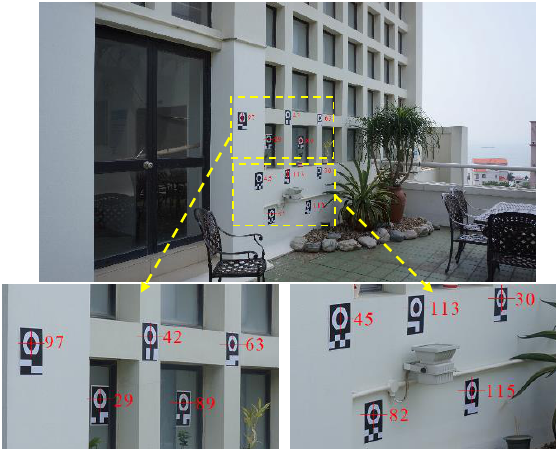
Figure 5. Identification and location of the coded